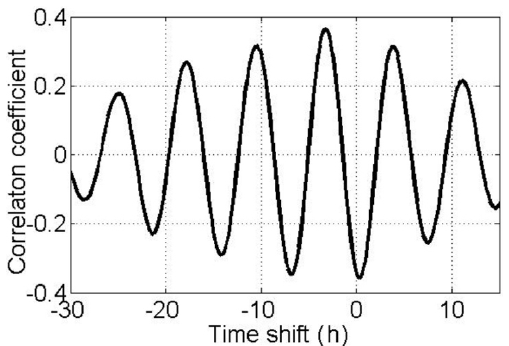
Figure 10. Correlation function between the vertical displacements of the isotherms of 11 and 6.8 ◦ C measured at station W1 in